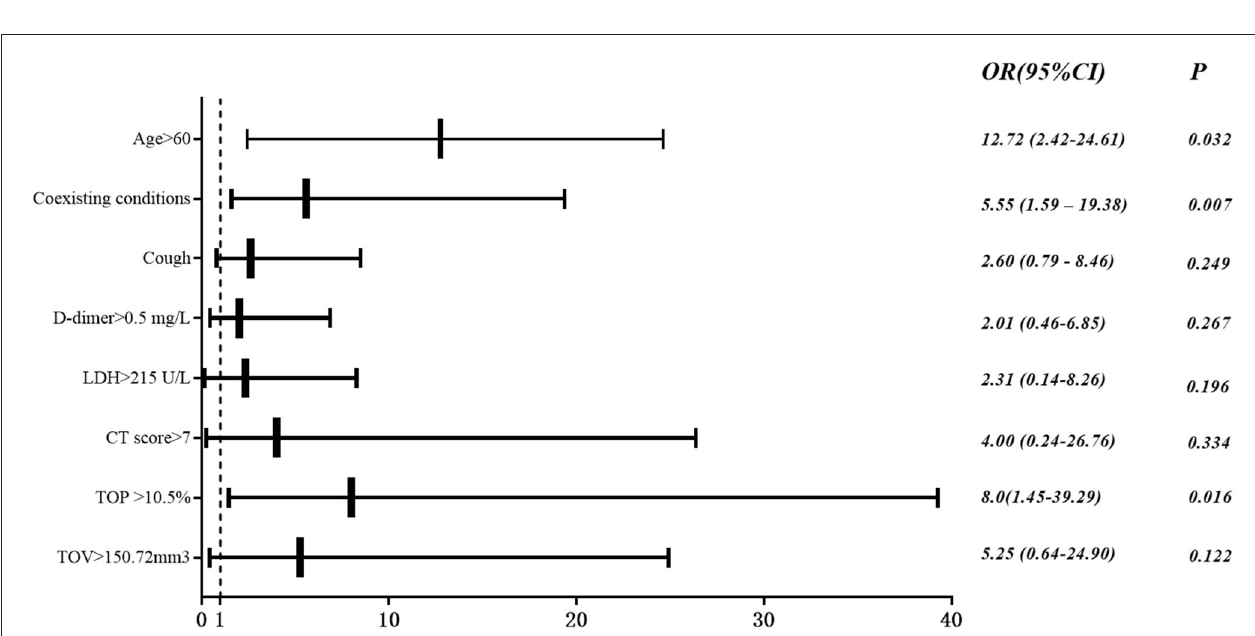
FIGURE 8 | Multivariate logistic analysis. Odds ratio (OR) and 95% CI of ICU group vs. non-ICU group based on multivariable logistic regression for clinical and imaging features.